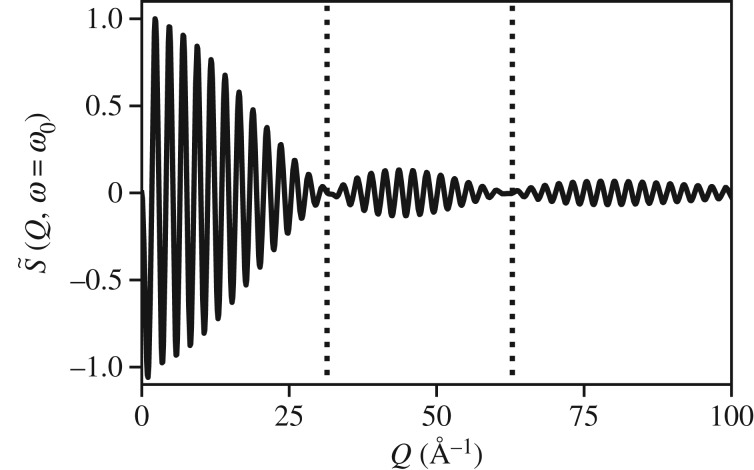
Extended range of S~(Q,ω=ω0) for the wave function shown in figure 8. Nodes exist at 2π/A and 4π/A, where A ≈ 0.2 Å.